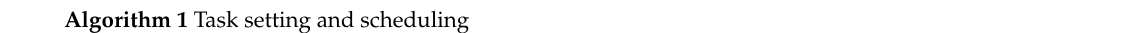
Algorithm 1 Task setting and scheduling